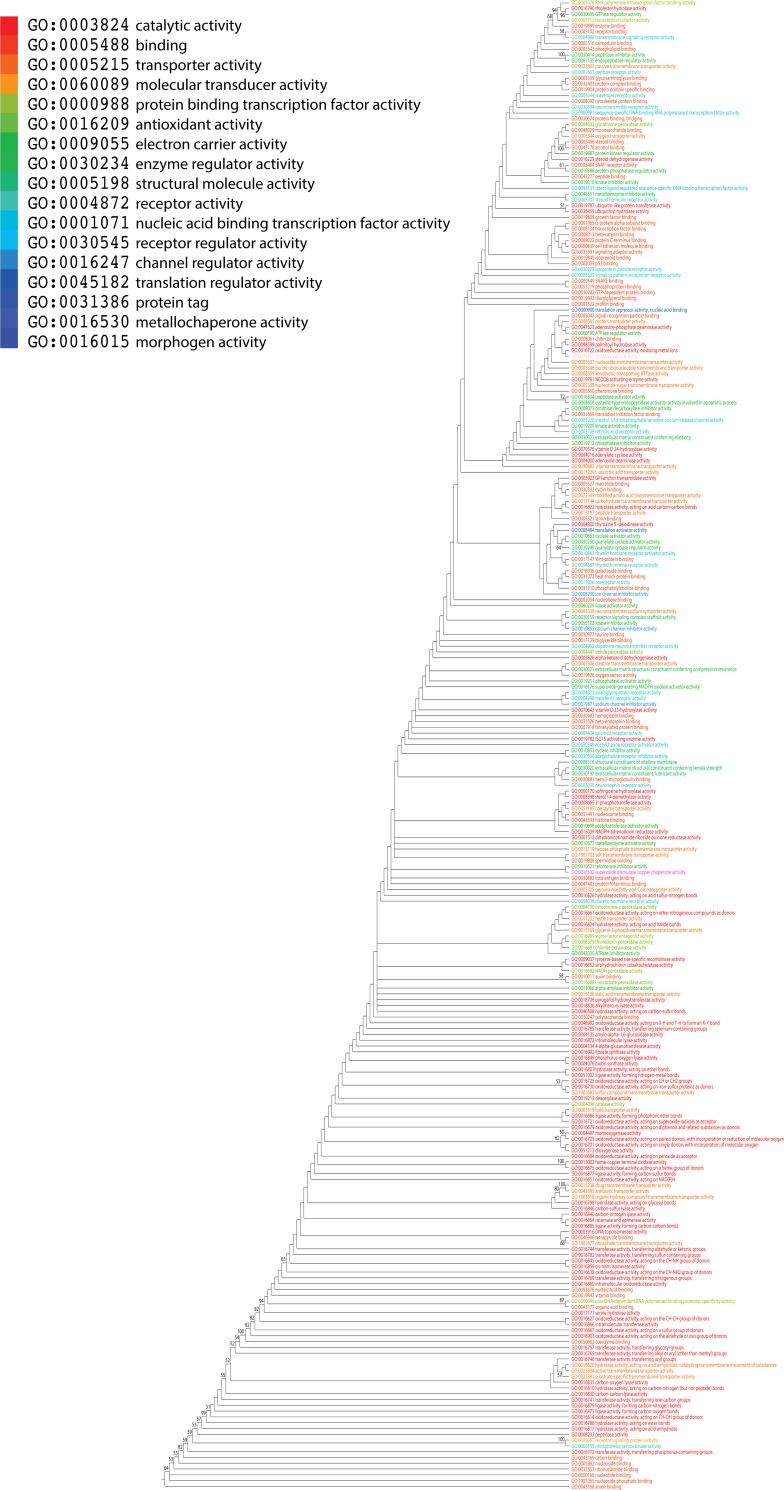
A ToF potraying evolution of level 3 GO terms.Molecular functions are colored according to corresponding level 1 GO terms. Nonparametric BS values are shown above branches, which are supported by more than 50% of 1,000 replications. The tree was rooted by the Lundberg method. Tree length = 24,364; RI = 0.88; CI = 0.24; Hi = 0.76; and g1 = -0.32.